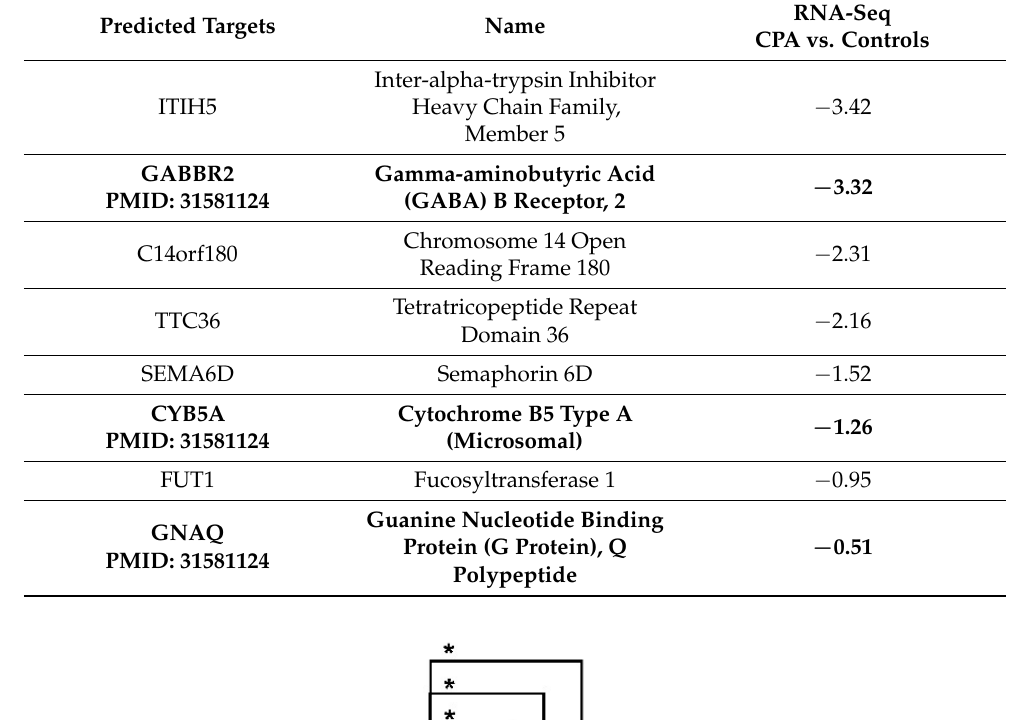
Table 1. Analysis of the predicted targets of miR-1247-5p and their expression levels in comparison to controls (log2 fold change). Published literature on target genes in reference to CS is highlighted in bold.